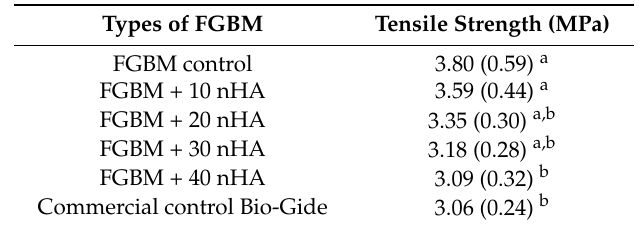
Table 2. Means (Standard deviations) of tensile strength of functionally graded bilayer membrane (FGBM) with different composition ( n = 6) # .